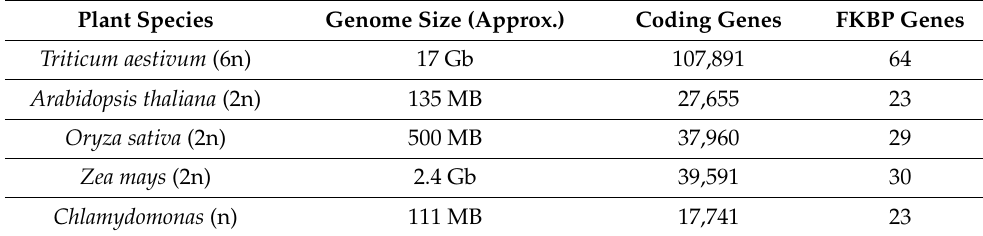
Table 2. Number of FKBP proteins in different plant